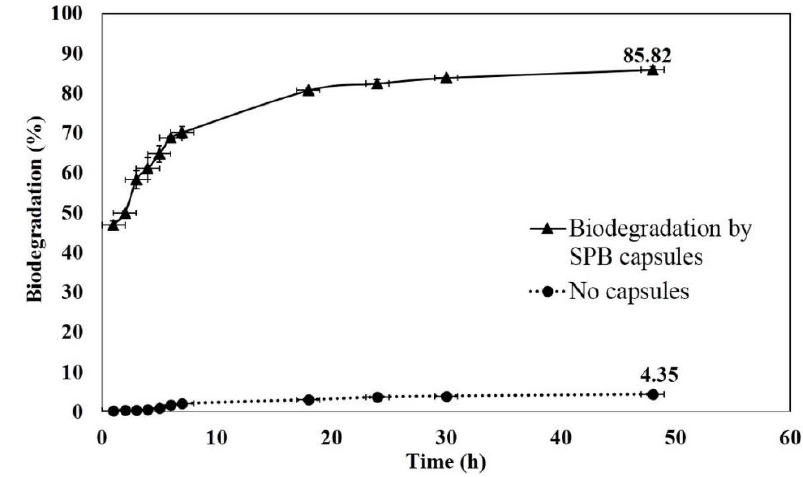
Figure 6. Biodegradation of 3 ppm EE2 in 10 mM phosphate bu ff er by R. zopfii -containing SBP capsules.